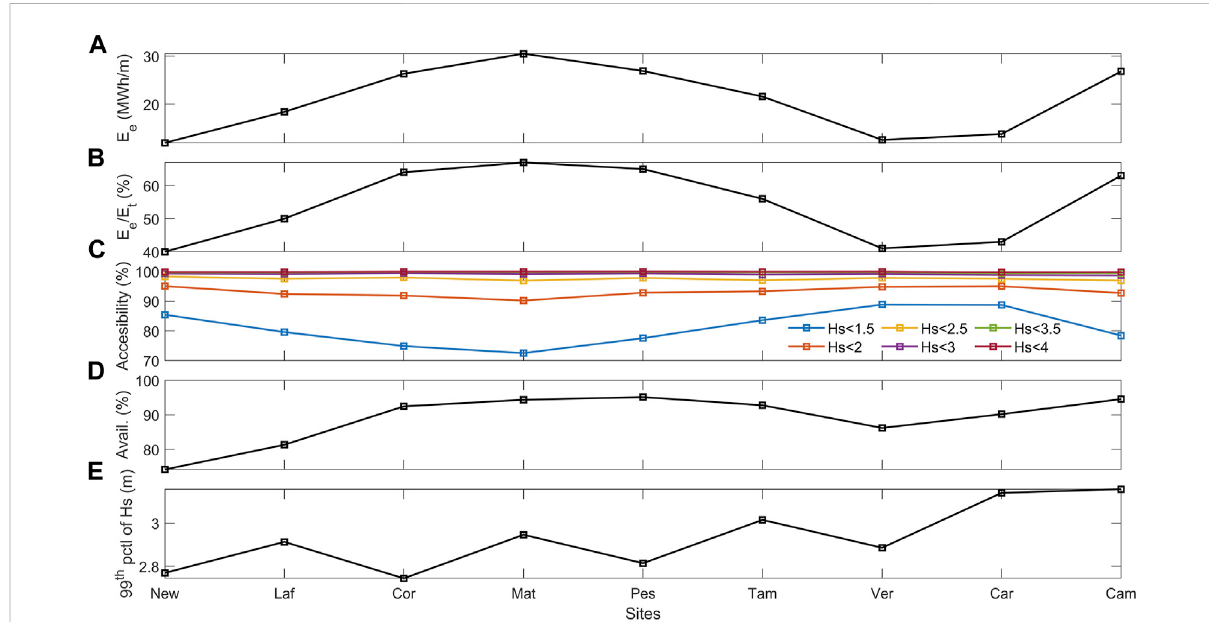
FIGURE 11 (A) Annual Exploitable energy; (B) percentage of the ratio of exploitable energy to total energy; (C) annual accessibility; (D) annual availability; and (E) 99th percentile values of H s for different locations in 9 sites in the GoM.